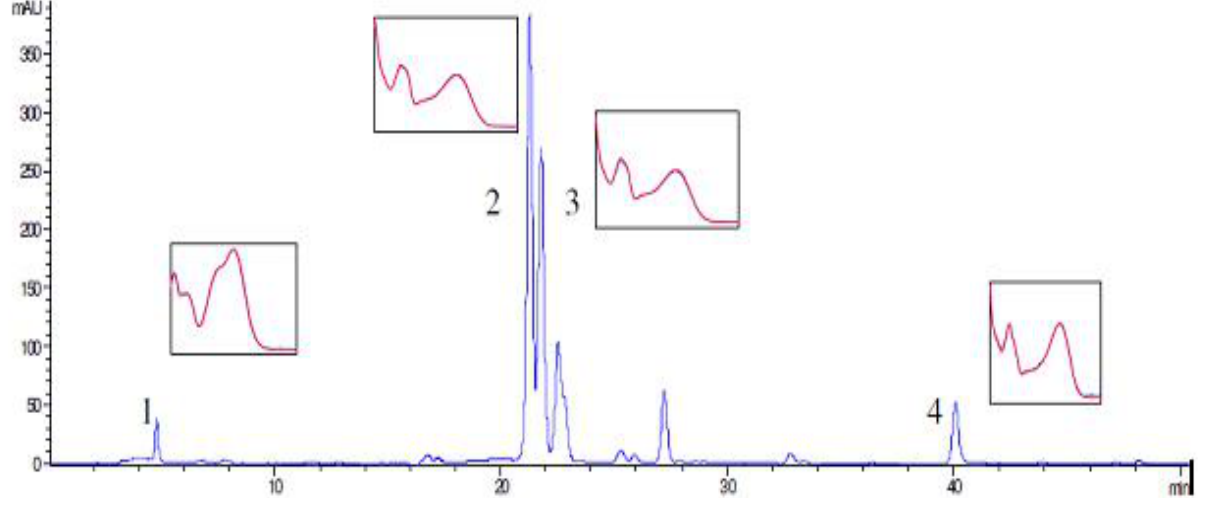
Figure 1. HPLC profile of SJW methanolic extract: (1) chlorogenic acid; (2) rutin; (3) hyproside; (4) quercetin.